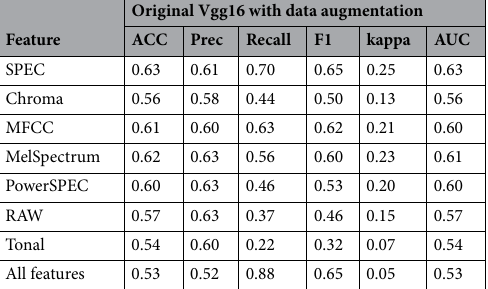
Table 5. Classification performance per feature per classifier (original Vgg16 with data augmentation) after 100 training epochs.